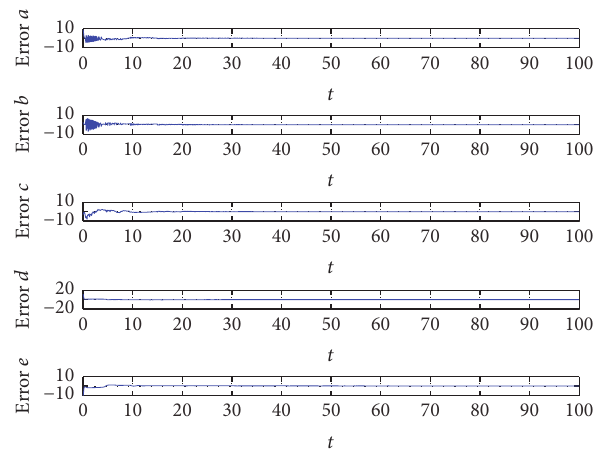
Figure 4: Time series of error of parameters I.